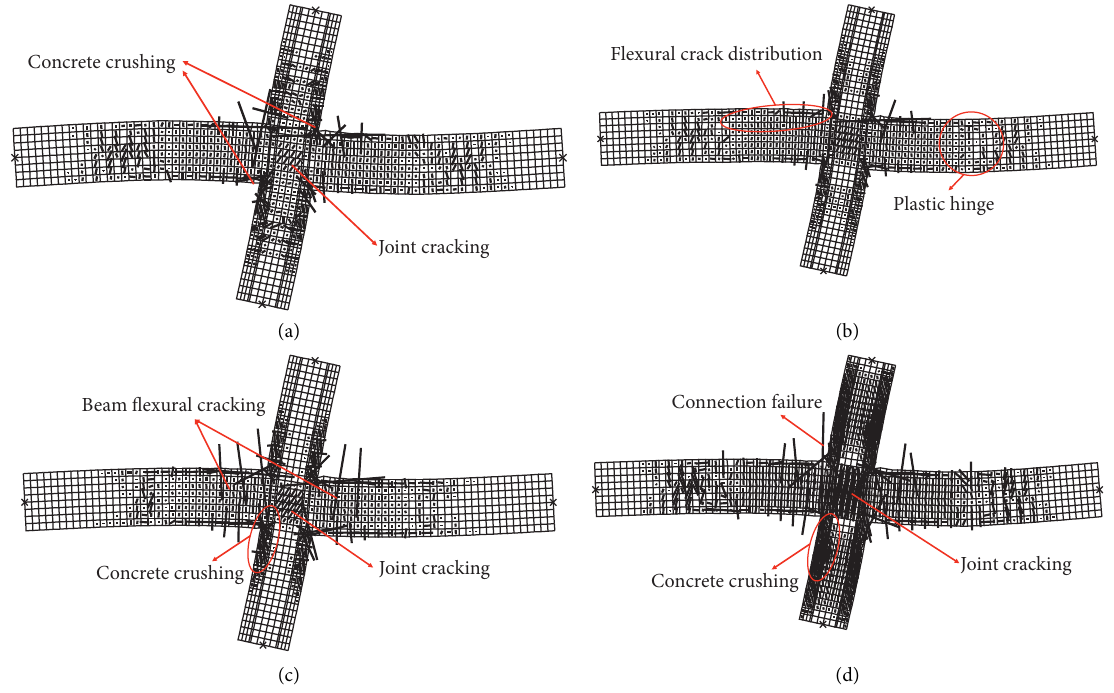
Figure 15: Crack pattern by axial load (specimen PC-I50-0.2). (a) Axial load ratio of 0.1. (b) Axial load ratio of 0.2. (c) Axial load ratio of 0.3. (d) Axial load ratio of